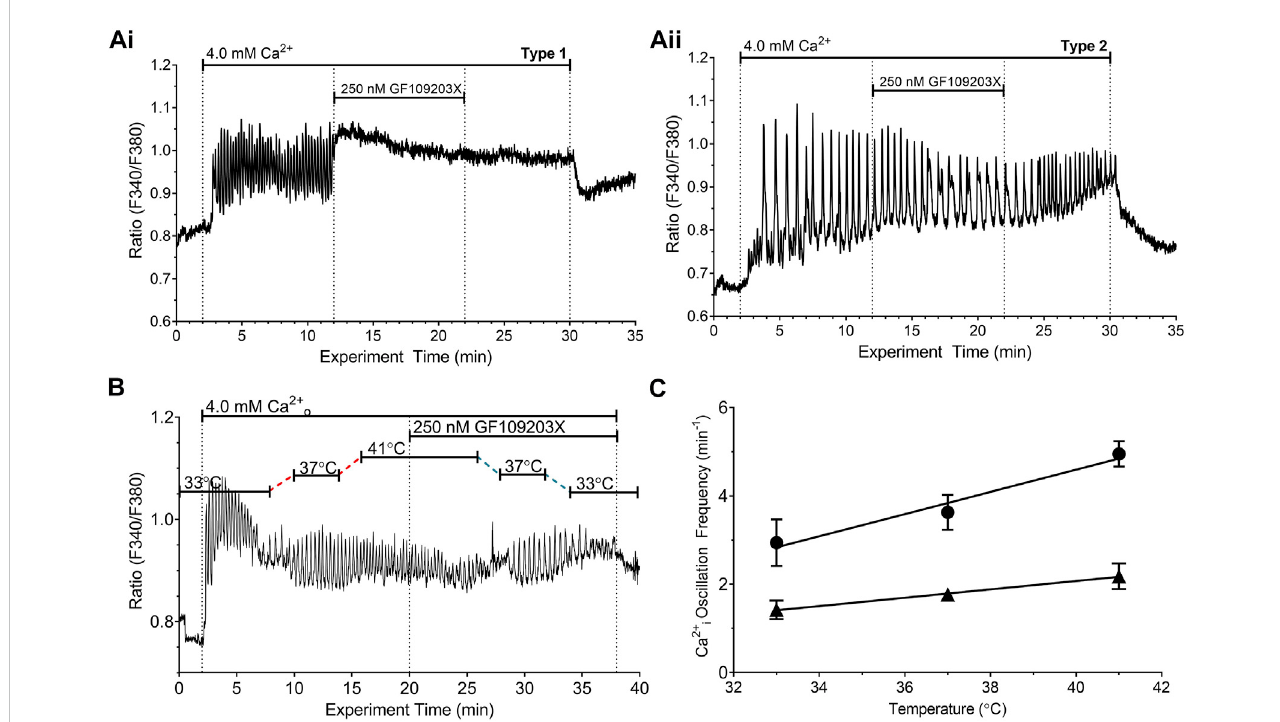
FIGURE 6 Effect of protein kinase C inhibitor on temperature-dependent modulation of the frequency of Ca 2+ o -induced Ca 2+ i oscillations. HEK-CaSR cells were loaded with fura-2 AM then exposed to 4.0 mM Ca 2+ o in the absence or presence of the PKC inhibitor GF109203X and the temperature was adjusted in the range 33 ° C — 41 ° C. At the physiological control temperature, 37 ° C, GF109203X (250 nM) either (i) converted Ca 2+ i oscillations into sustained responses (Type 1 response, ~60% of cells; Panel (Ai, ii) reduced the frequency of Ca 2+ i oscillations (Type 2 response, ~40% of cells; Panel (Aii) . Panel (B) shows a representativetracefromasingle cellthat wasexposedto 4.0 mMCa 2+ o and threedistinct temperatures (33,37 ° C and41 ° C). Ca 2+ o -inducedCa 2+ i oscillations persisted upon exposure to GF109203X permitting analysis of the effect of the inhibitor as the temperature was re-adjusted to the control level. Panel (C) shows the relationships between temperature and Ca 2+ i oscillation frequency for HEK-CaSR cells exposed to 4.0 mM Ca 2+ o in the absence (circles) or presence (triangles) of GF109203X (250 nM). The data were obtained in six independent